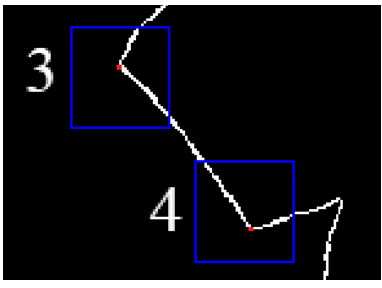
Figure 13. Characterized points of sleeve. Collar width: